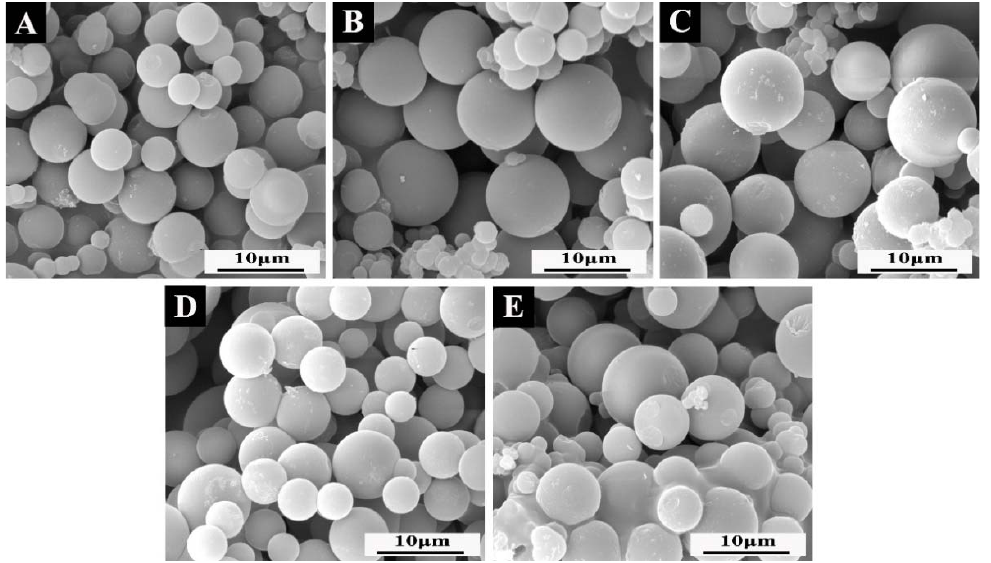
Figure 8. The SEM morphology of microcapsules: ( A ) sample #10; ( B ) sample #11; ( C ) sample #12; ( D ) sample #13; ( E ) sample #14.